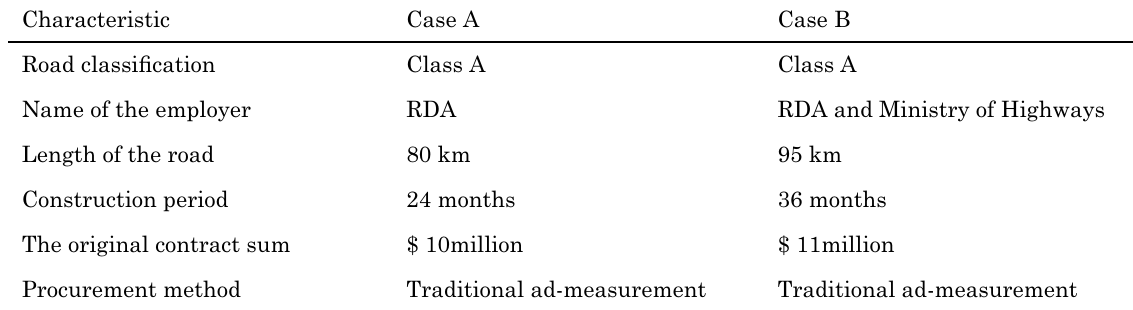
Table 1. Details of cases